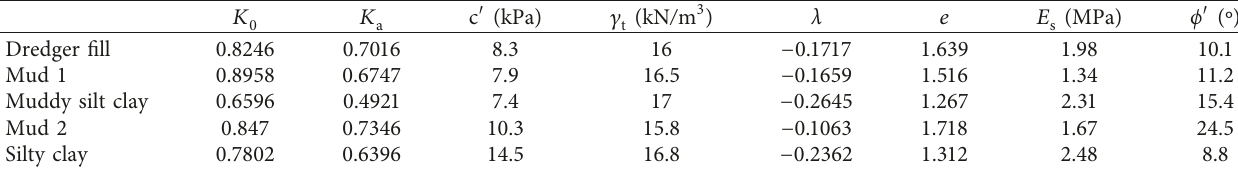
Table 2: Parameters for the soil at Wenzhou Vocational Secondary School Foundation. K